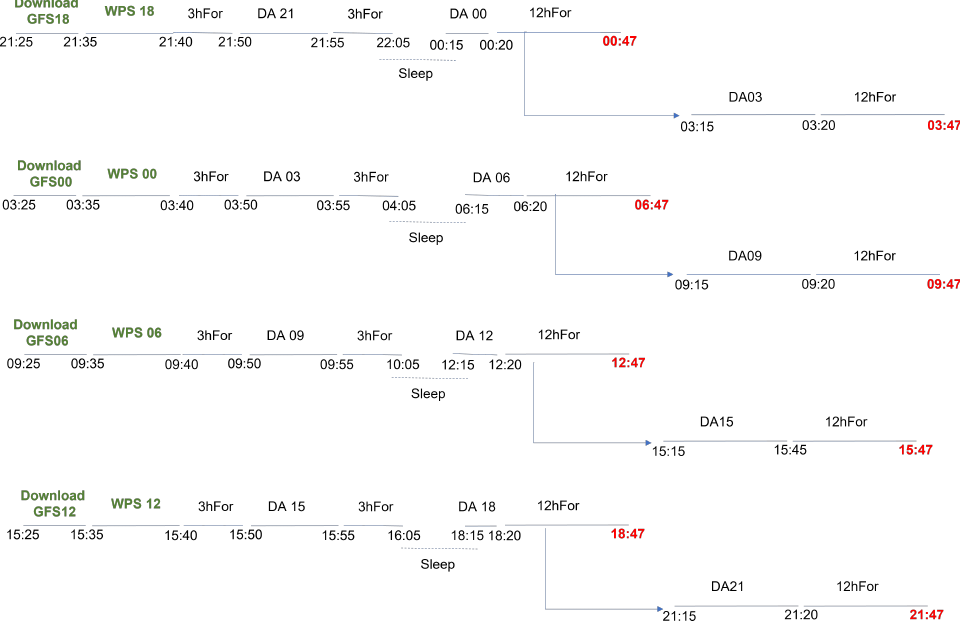
Figure 2. Nowcasting scheme with the operational timing obtained with the available HPC